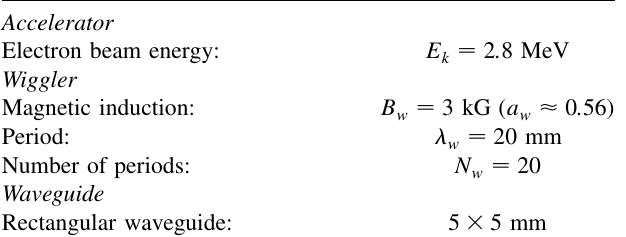
TABLE I. Operational parameters for THz FEL.